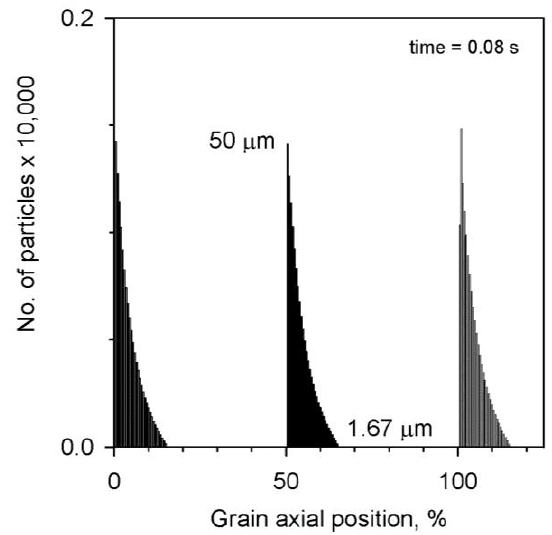
Figure 11. For the simulated firing of Figure 10, the particle size distribution in the element, at different positions along the propellant grain, before the introduction of the initial pressure pulse disturbance.